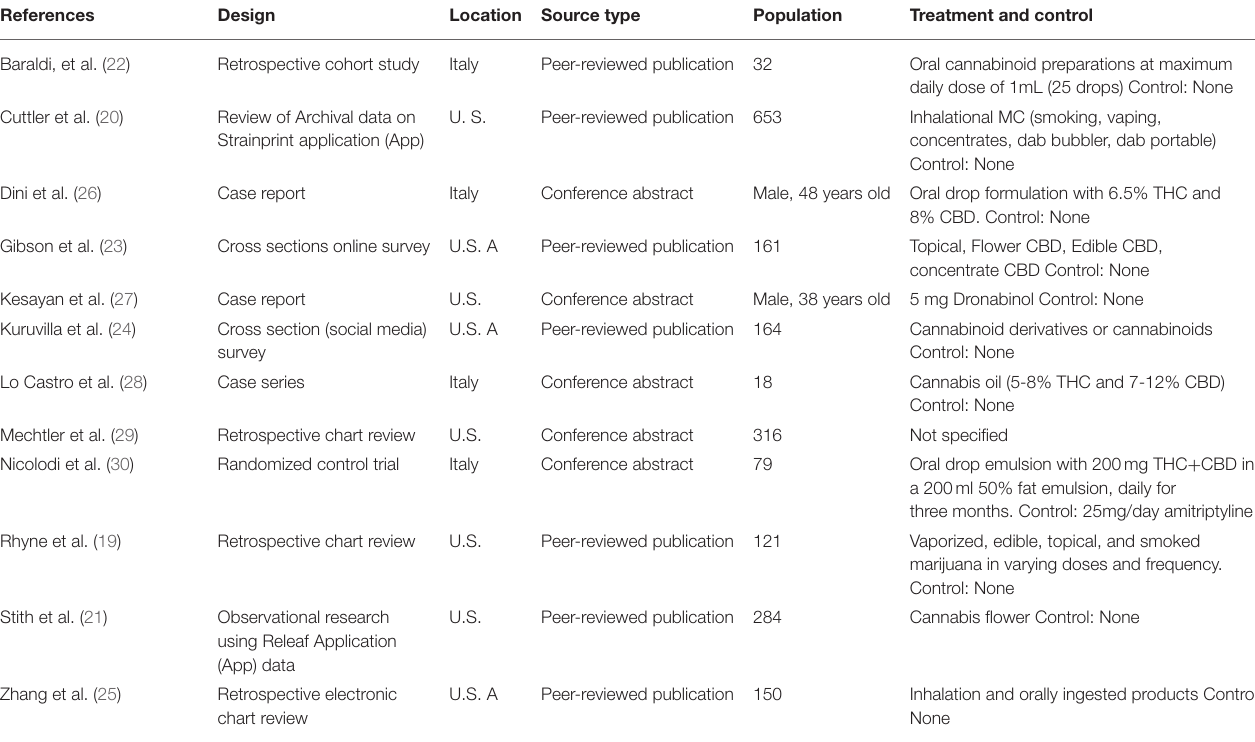
TABLE 1 | Study characteristics, population, treatment, outcomes, and findings of included